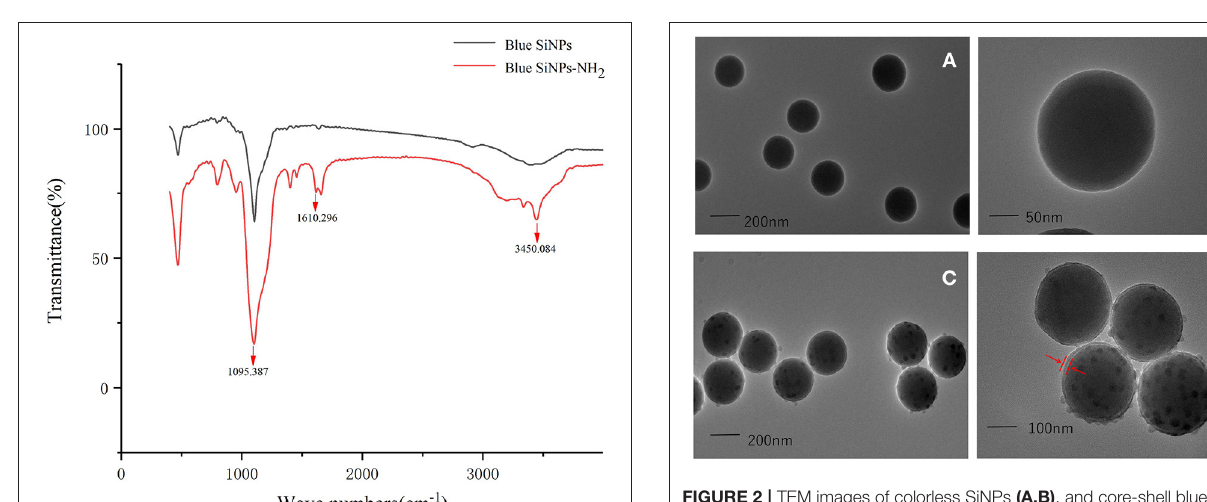
FIGURE 2 | TEM images of colorless SiNPs (A,B) , and core-shell blue SiNPs (C,D) . The red arrow means that a layer of silica shell has been successfully wrapped on the outside of the silica nanoparticles, and the position of the shell is marked with the red arrow. the results of TEM showed that blue SiNPs were successfully prepared in this